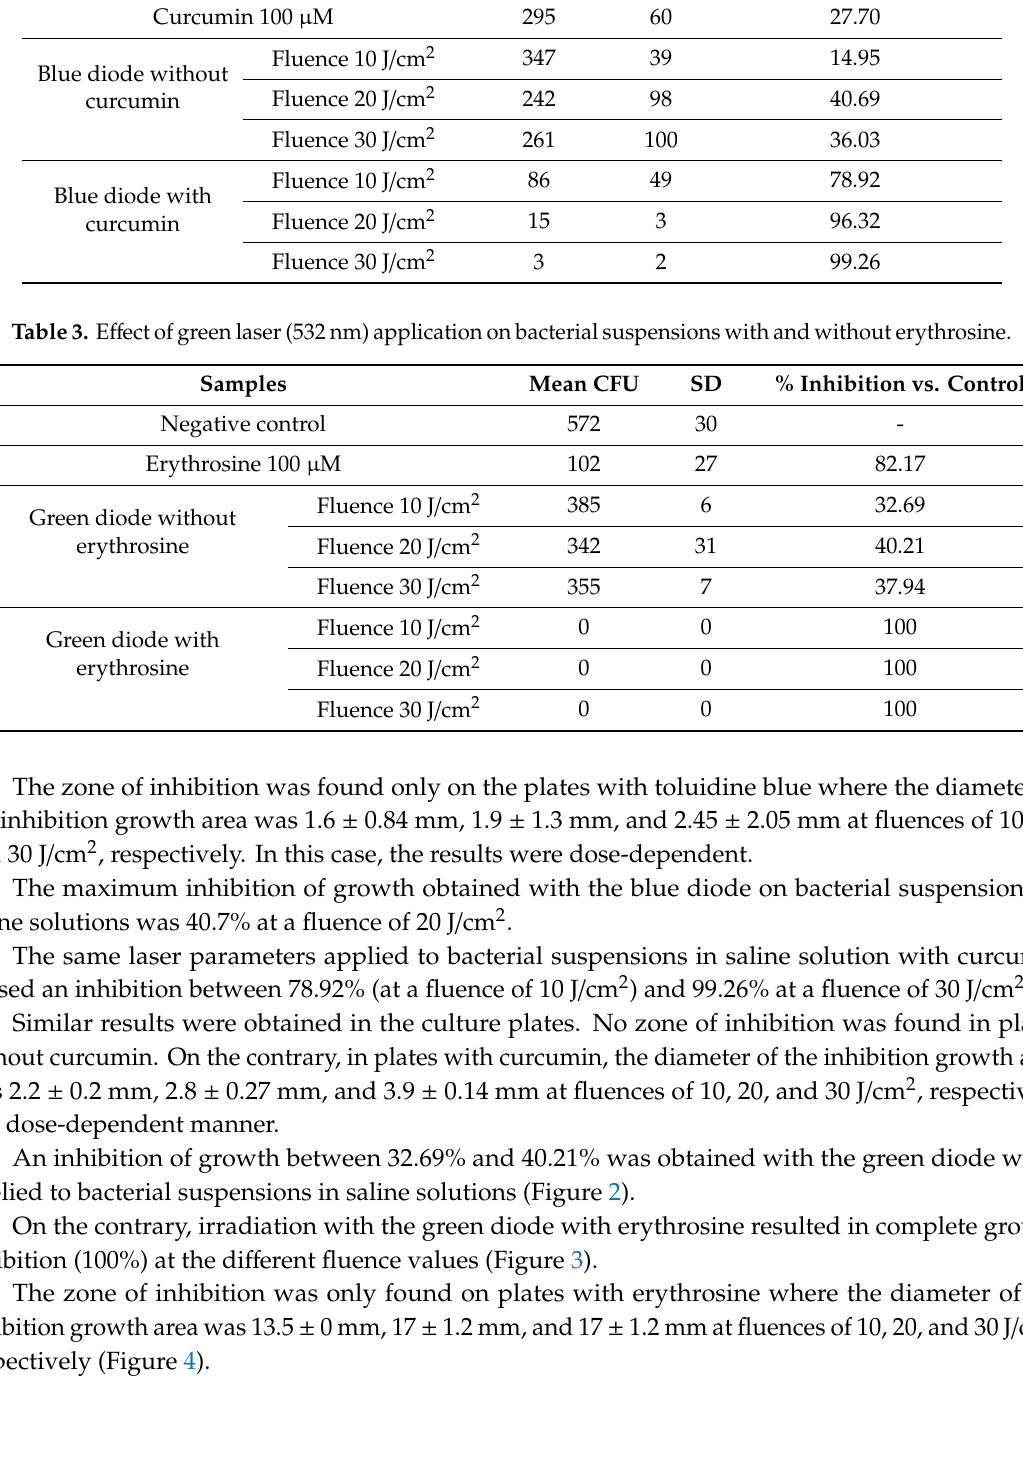
Table 2. E ff ect of blue laser (405 nm) application on bacterial suspensions with and without curcumin. Samples Mean CFU SD % Inhibition vs. Control Negative control 408 19 - Curcumin 100 µ M 295 60 27.70 Fluence 10 J / cm 2 347 39 14.95 Blue diode without Fluence 20 J / cm 2 curcumin